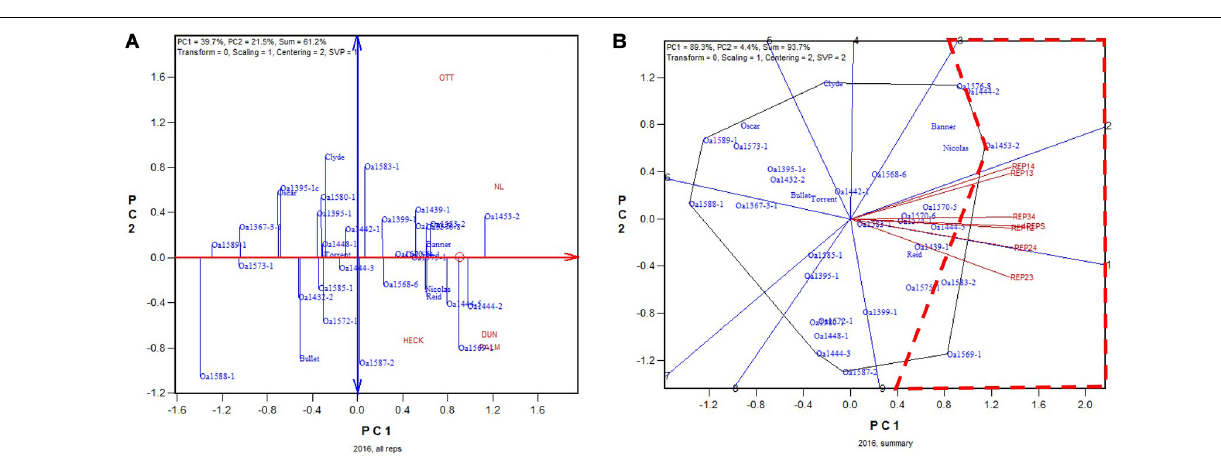
FIGURE 5 | Biplots for the 2016 Ontario trials. (A) GGE biplot to show genotype ranking based on data from all four replicates, and (B) summary biplot to show the genotype rankings based on all four replicates and on any two of them. 4REPS, genotypic ranking based on all four replicates; REP12, genotypic ranking based on replicates 1 and 2; REP13, genotypic ranking based on replicates 1 and 3, and so